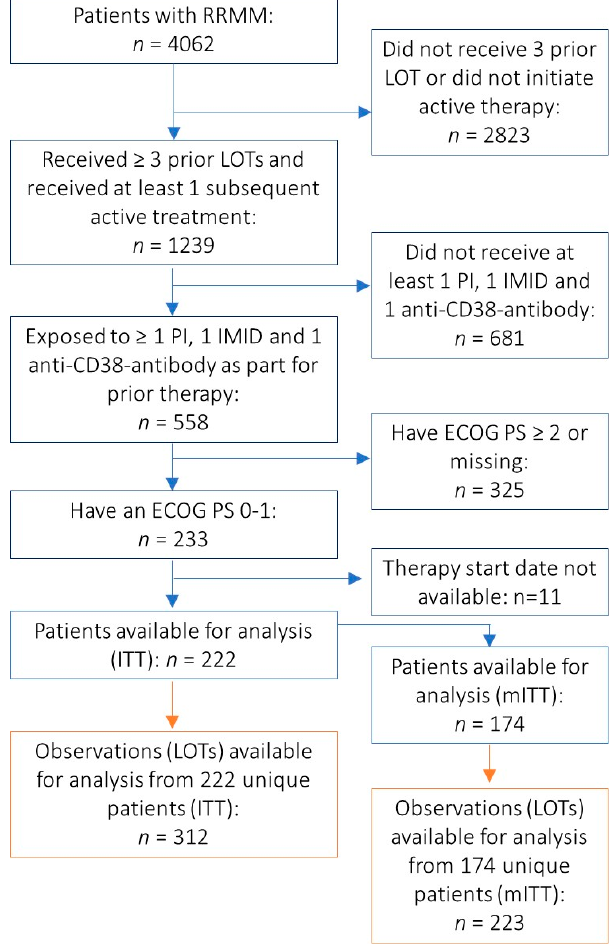
Figure 1. Patient Selection for Therapie Monitor Cohort from Therapie Monitor. Abbreviations: ECOG PS, Eastern Cooperative Oncology Group performance status; IMID, immunomodulatory drug; ITT, intention to treat; LOT, line of therapy; PI, proteasome inhibitor; RRMM, relapsed and refractory multiple myeloma.